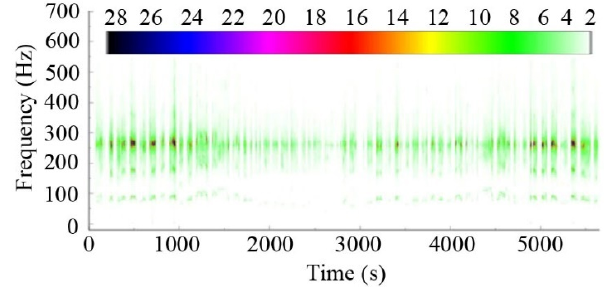
Figure 10. Spectral diagram of the wheelset lifting mechanism.